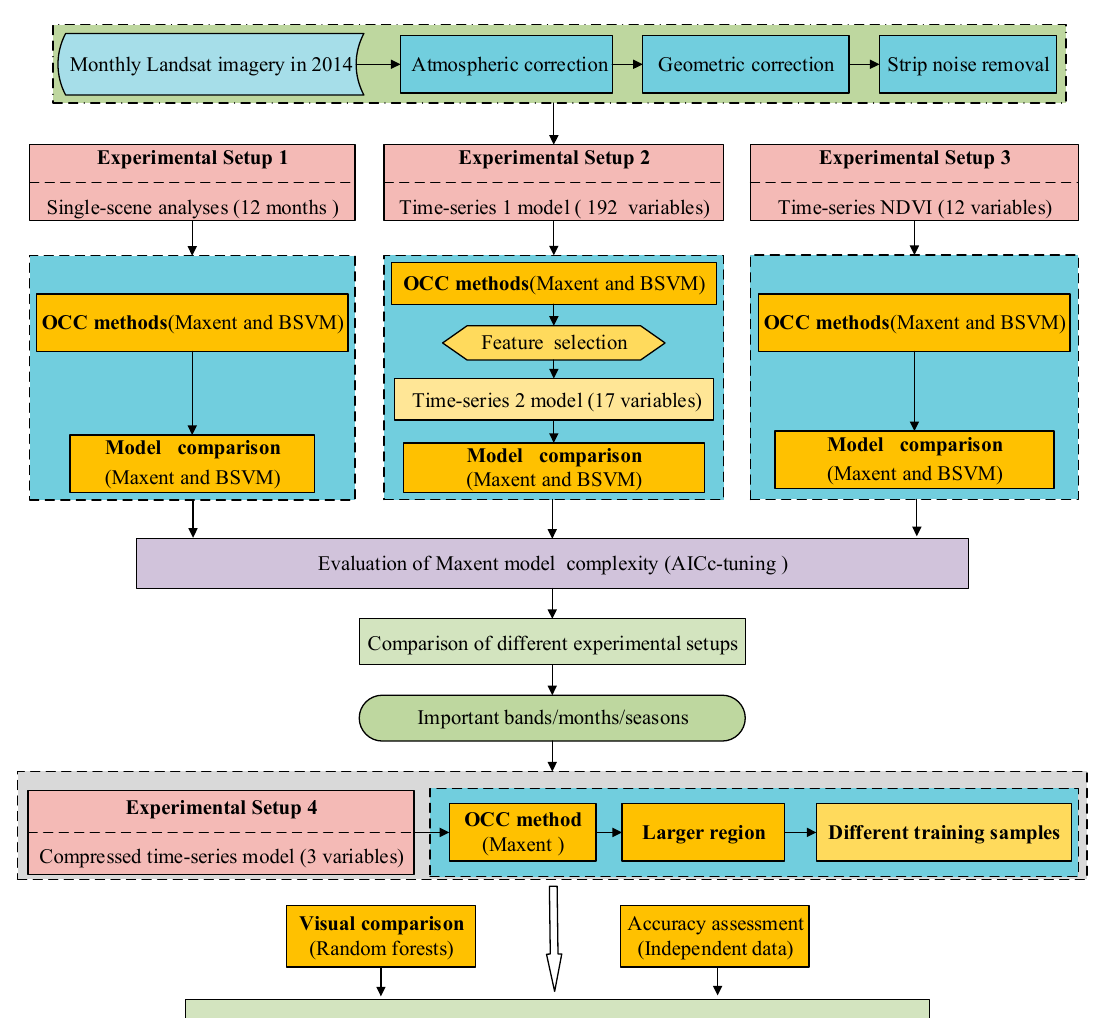
Figure 2. Flowchart of the One-Class Classification (OCC) methods to detect S. alterniflora based on monthly Landsat time-series. BSVM, Biased Support Vector Machine.